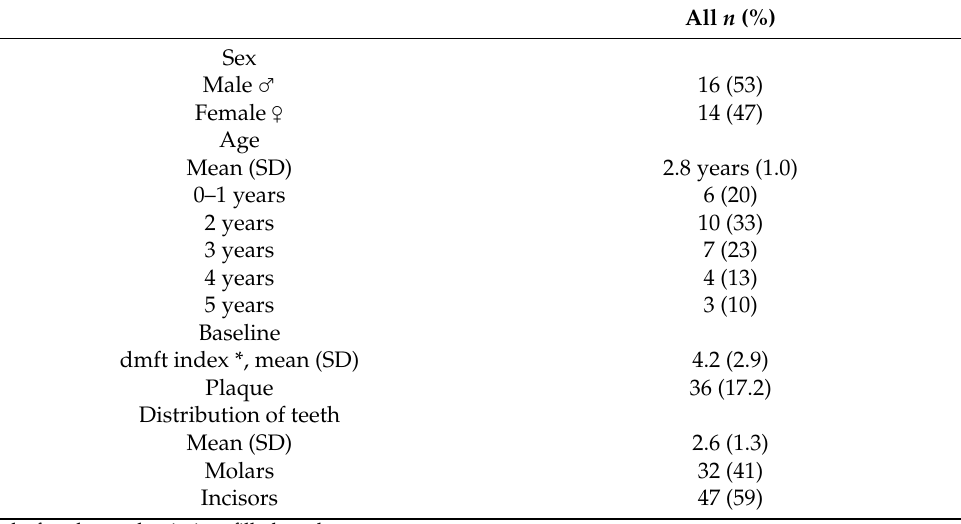
Table 1. Summary of Sample Data ( n = 30